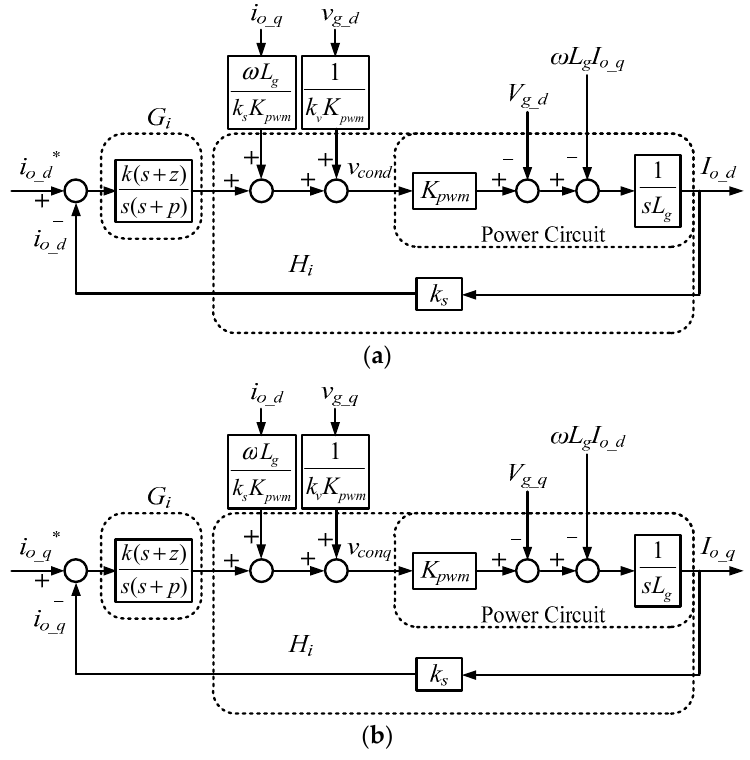
Figure 5. Inner inductor current control loops (* indicates commands) : ( a ) d-axis; ( b ) q-axis.